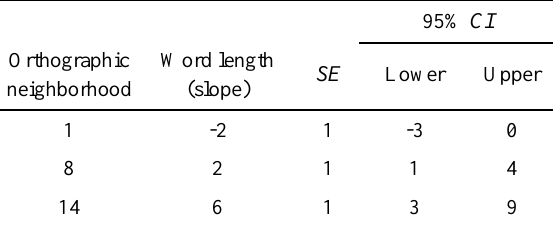
Table A1. First-fixation duration: Interaction of word length and orthographic-neighborhood size.